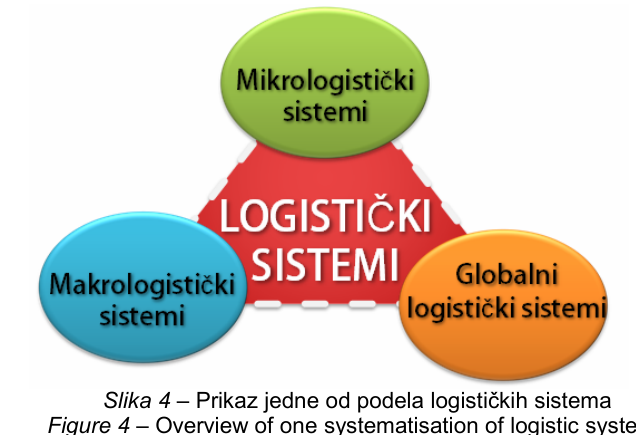
Рис . 4 – Некоторые разновидности логистических